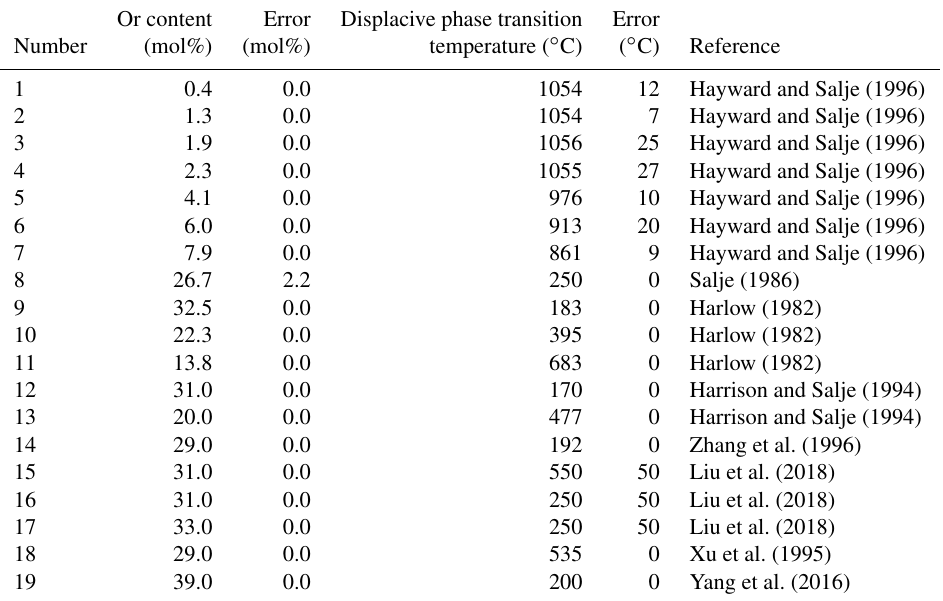
Table 1. The data of displacive phase transition temperature of anorthoclase with different Or contents from the literature. The errors unreported in those references are listed as zero here. For the transition temperature of anorthoclase from Xu et al. (1995), it was suggested to lie between 535 and 440 ◦ C characterized by the structural variations during heating and cooling, respectively. Thus, we here cited the critical temperature of 535 ◦ C for comparison with our data of heating